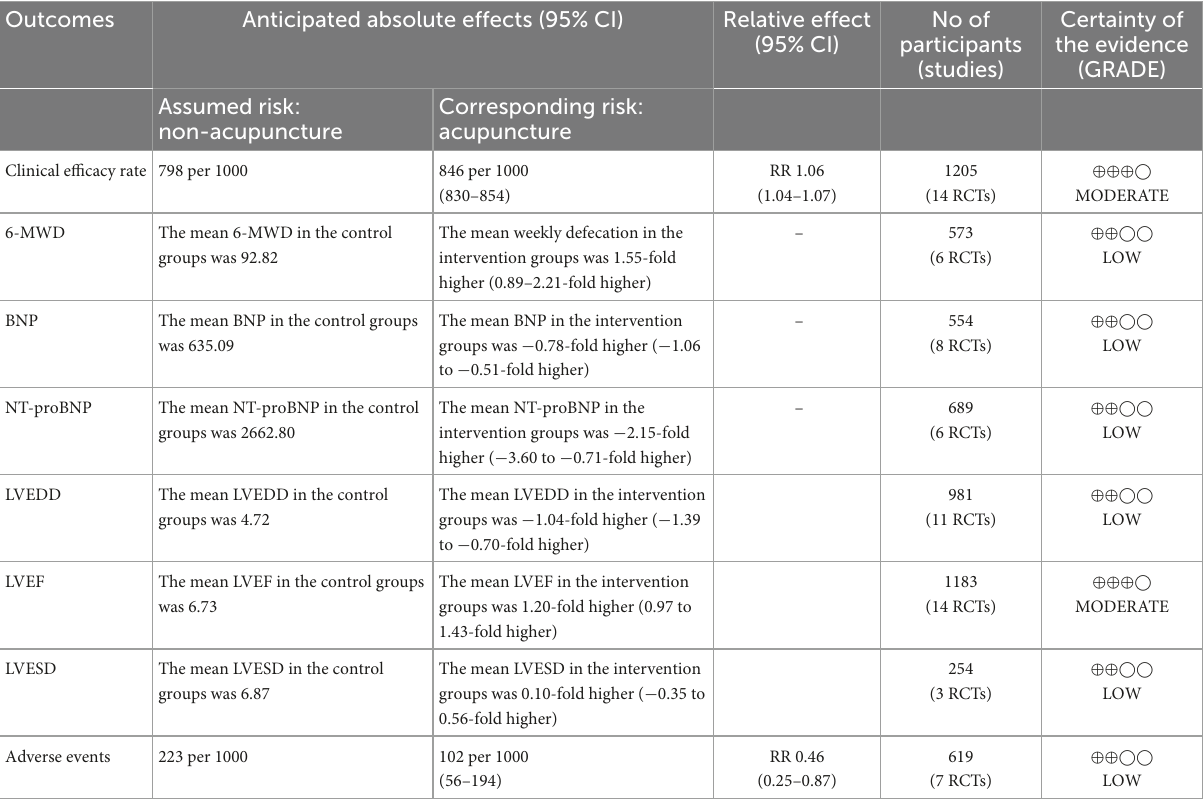
TABLE 3 GRADE summary of comparing QLQX plus RT group with RT